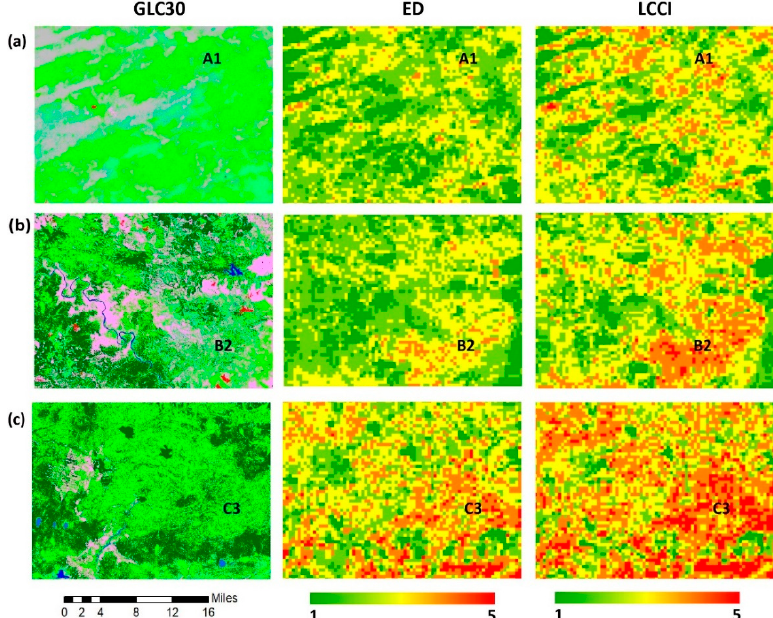
Figure 6. Examples of land cover heterogeneity captured by ED and LCCI. The panels from left to right are GlobeLand30, ED, and land cover complexity. ( a ) Desert and grassland mosaic regions in the west of the Sahel region (15°56 ′ N, 14°56 ′ W). The LCCI captures more patch detail of the land cover heterogeneity (A1); ( b ) diverse cropland region in East Africa (29°1 ′ S, 31°17 ′ E). The LCCI captures a large amount of heterogeneity because of the high land cover diversity (B2); ( c ) region with a landscape of forest fragmentation and grassland in Zambia (14°17 ′ S, 25°8 ′ E). The LCCI captures the extreme fragmentation feature of land cover better than ED (C3).